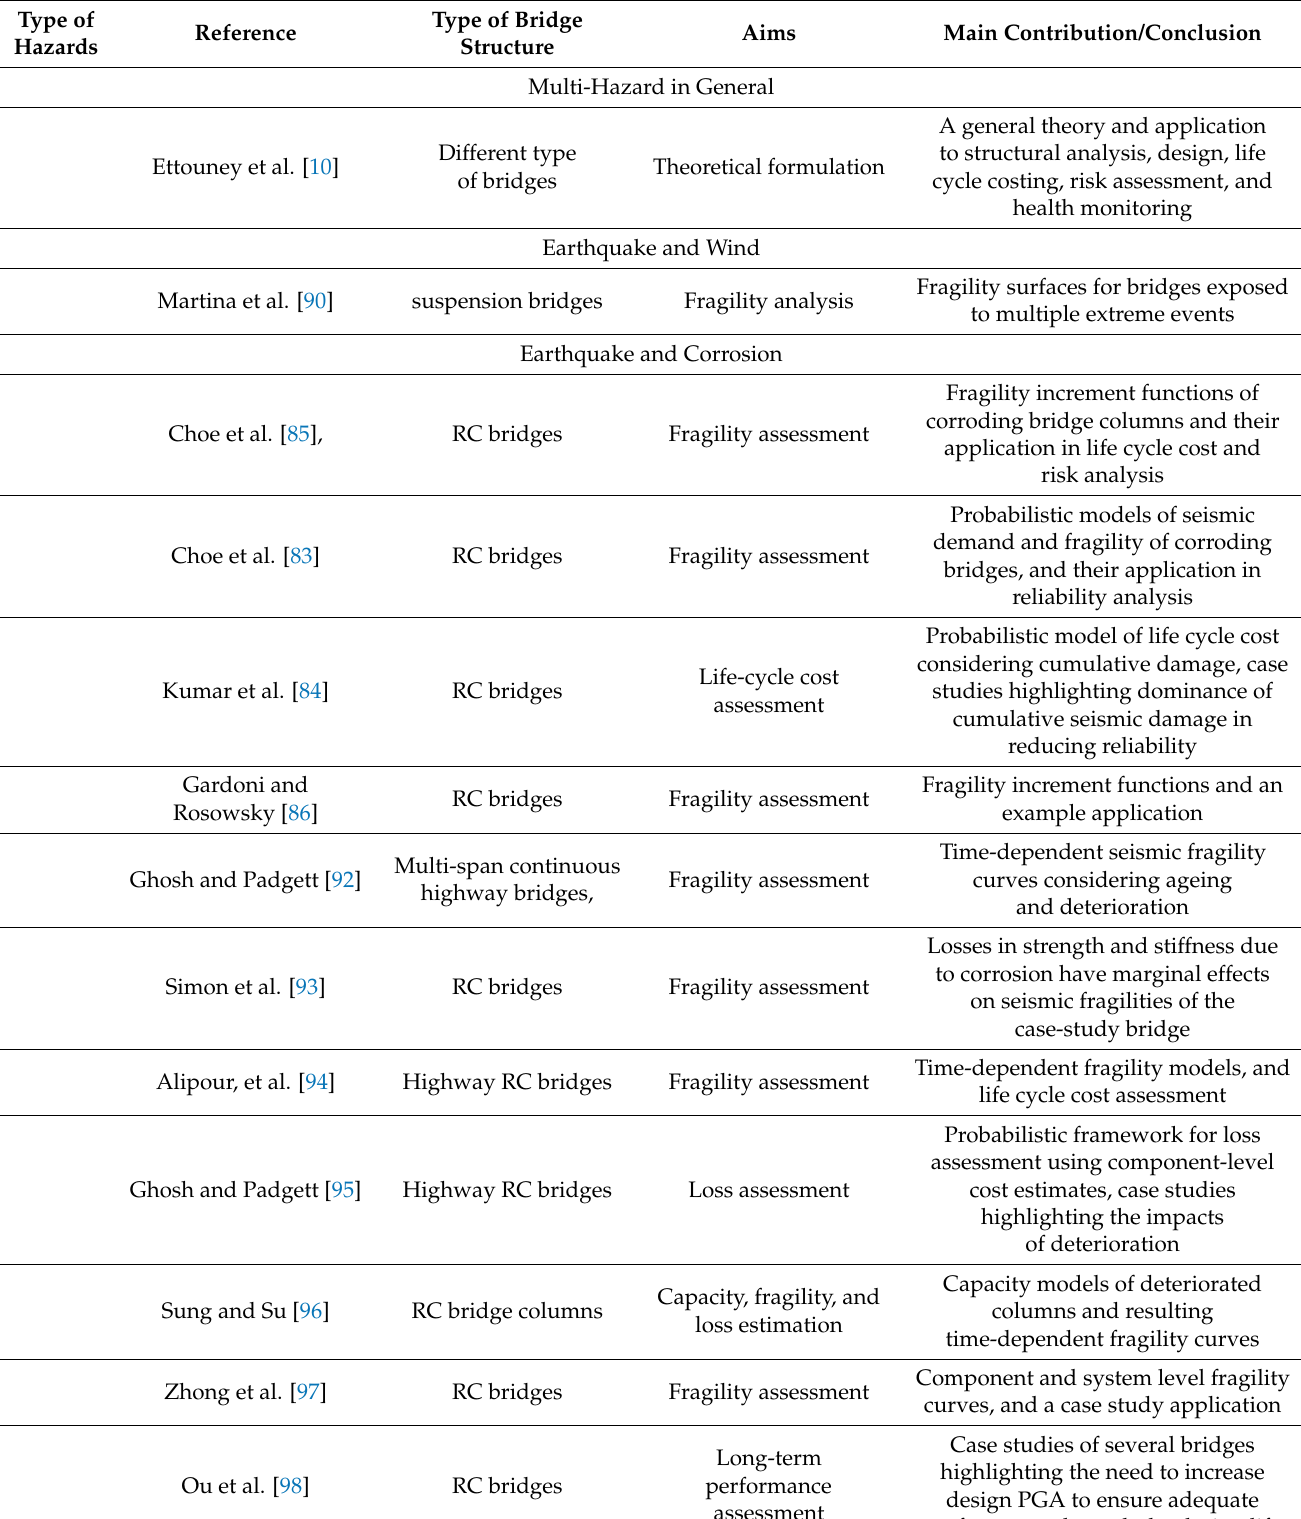
Table 1. A summary of published works on bridges subjected to